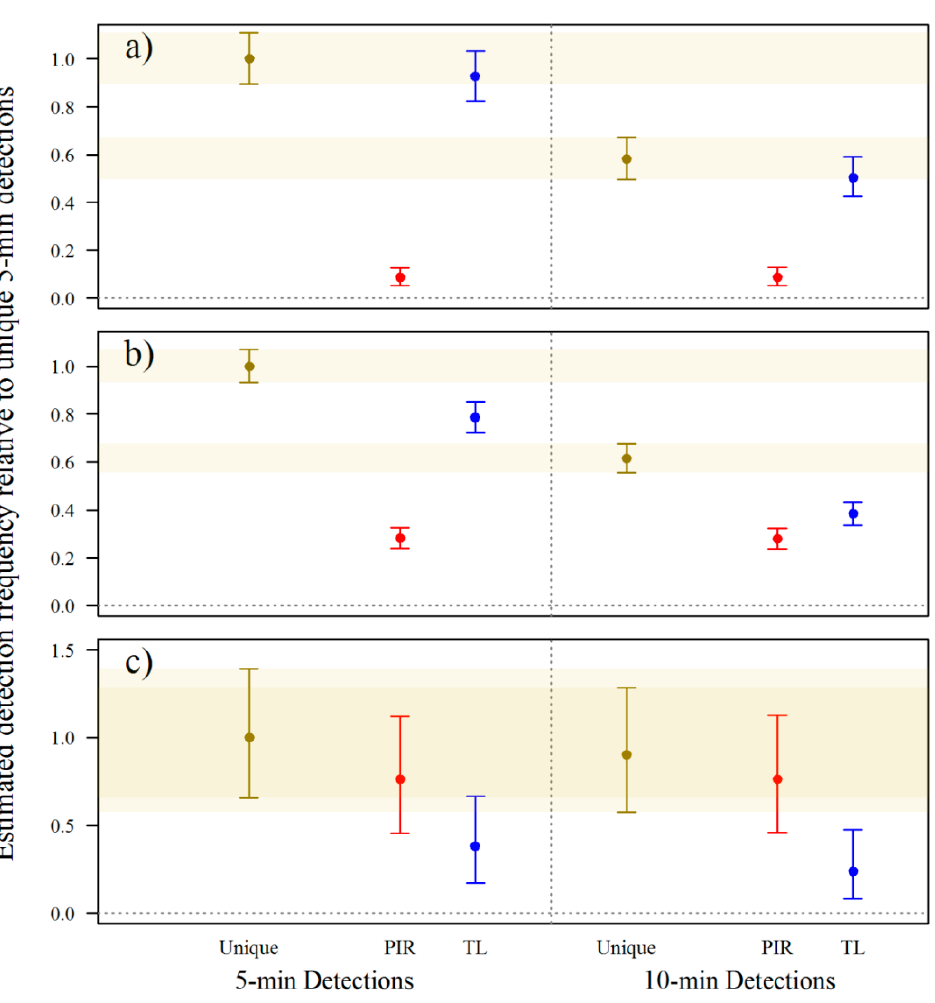
Figure 5. Estimated detection frequencies during the second experiment (Feb–Mar 2014) of ( a ) small lizards; ( b ) medium–large lizards; and ( c ) snakes as a function of trigger mechanism relative to unique 5-min detections. Trigger mechanism scenarios are unique detections, passive infrared (PIR) trigger only detections, and time-lapse (TL) trigger only detections. Central dots represent the mean of the posterior distributions and bars represent 95% credible intervals.